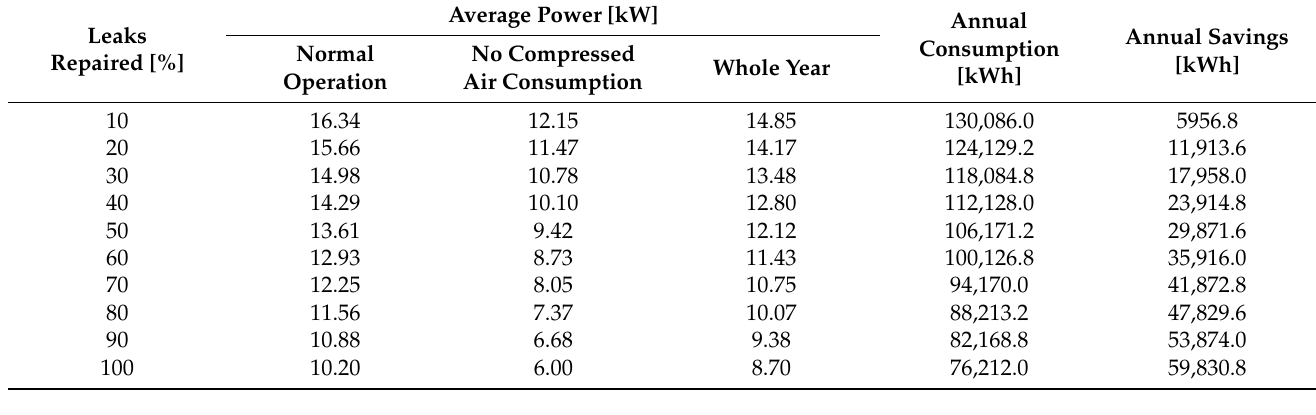
Table 9. Annual savings with the repair of compressed air leaks.